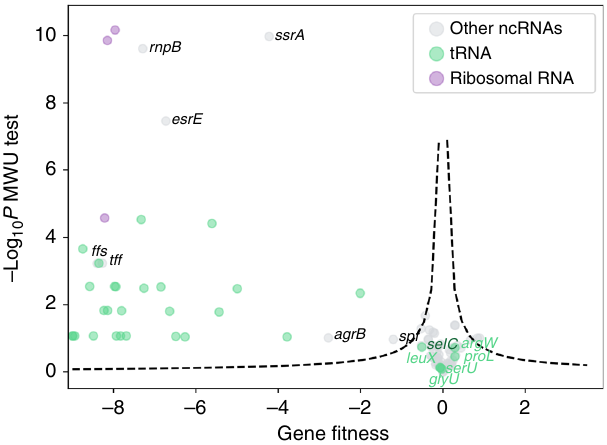
Fig. 4 CRISPRi screening maps ncRNA contributions to fi tness. Volcano plot of ncRNA-coding gene fi tness and − Log 10 P value of two-tailed MWU test. Dashed lines represent a threshold (FDR = 0.05) for calling hits based on the screening score (see Methods). Three groups of gene (each dot denotes a gene cluster with one or multiple genes, see Methods) are shown: purple, ribosomal RNAs; green, tRNAs; gray, other ncRNAs. Gene names for tRNAs that were not essential to E. coli identi fi ed by CRISPRi in rich medium and other ncRNAs reported to confer signi fi cant